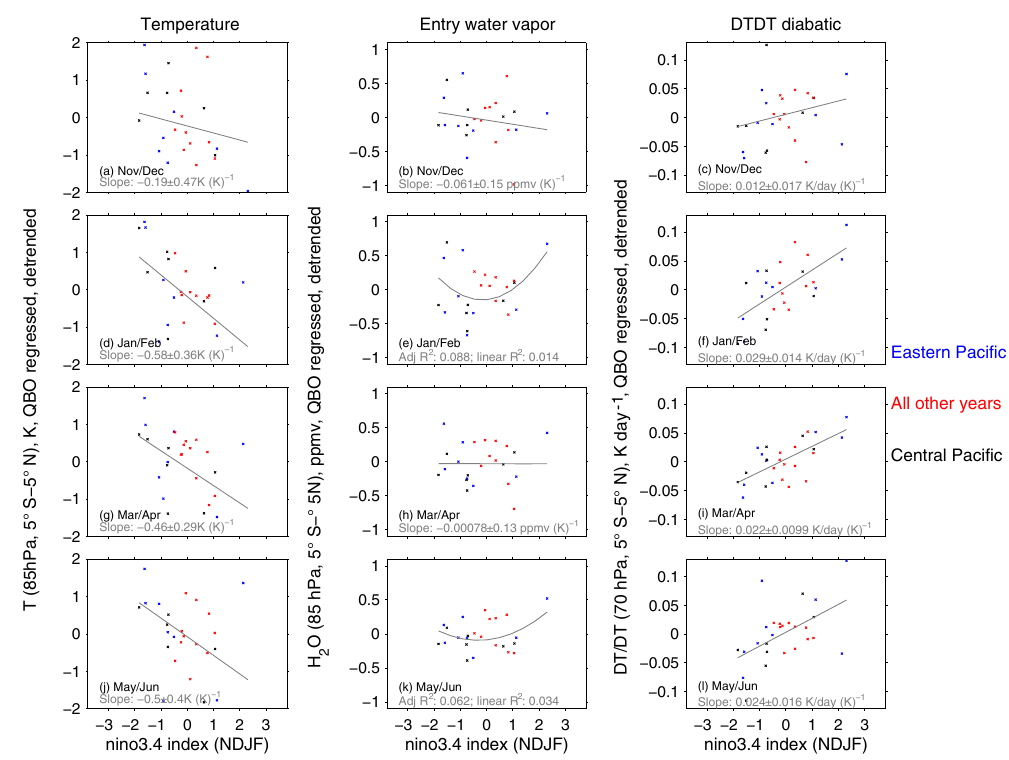
Figure 4. As in Figs. 2 and 3 but for the MERRA reanalysis ( a, d, g, j and c, f, i, l ) and SWOOSH (b, e, h, k) .